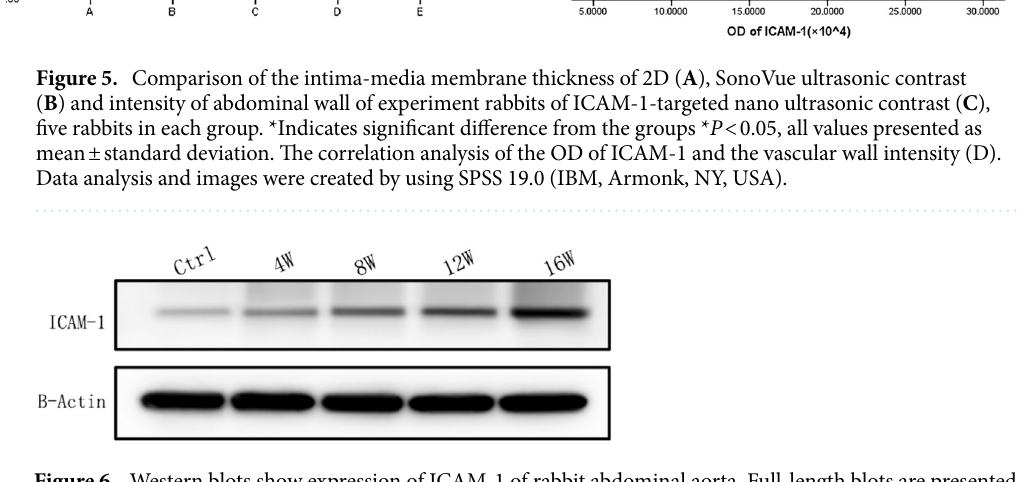
Figure 6. Western blots show expression of ICAM-1 of rabbit abdominal aorta. Full-length blots are presented in Supplementary Figure